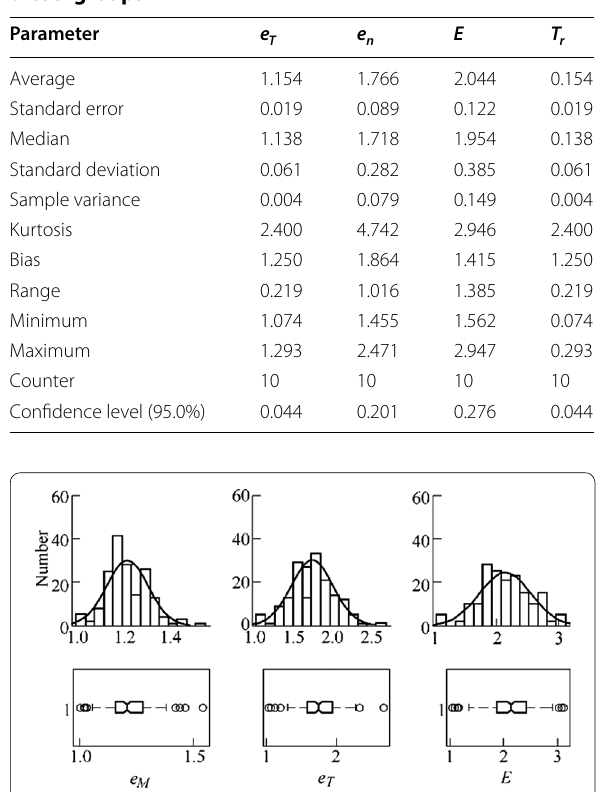
Table 10 Results of the calculations for naturally aspirated